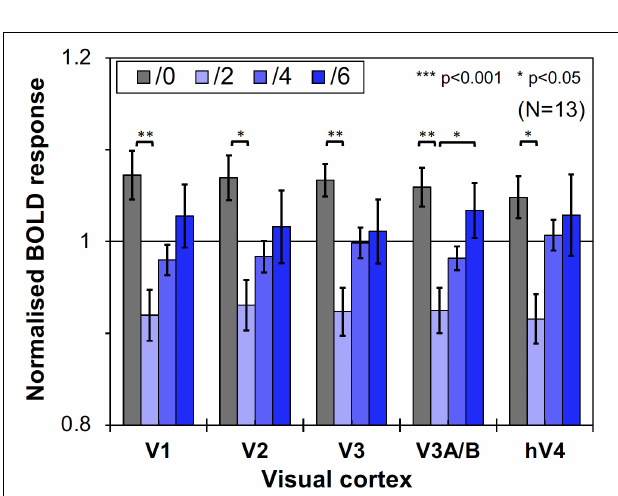
FIGURE 4 | Brain activity of visual cortices under the four Chroma conditions (/0, /2, /4, and /6). The vertical axis units are percent amount of signal change defined as incremental rate of BOLD response subtracted from the mean of the incremental rate under all four Chroma conditions in the stimulation phase. Error bars denote SEM. Asterisks denote statistical significance by Tukey’s honestly significant difference (HSD) test (** p < 0.01; * p < 0.05).